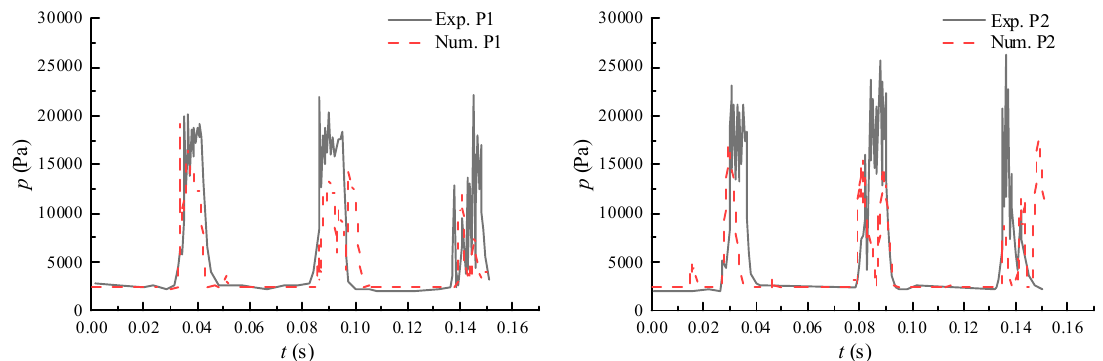
Figure 6. Pressure fluctuation on the suction surface of the hydrofoil at P1 and P2.